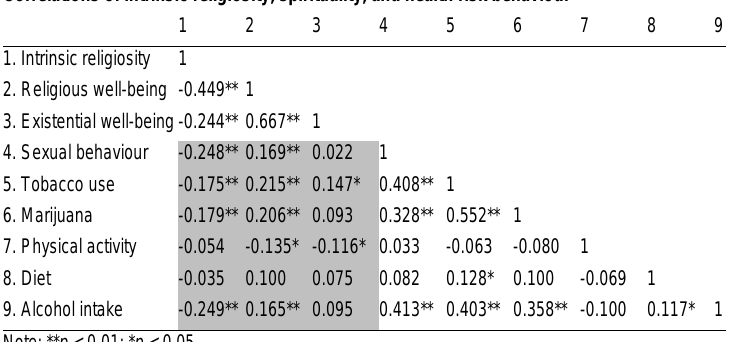
Correlations of intrinsic religiosity, spirituality, and health risk behaviour 1